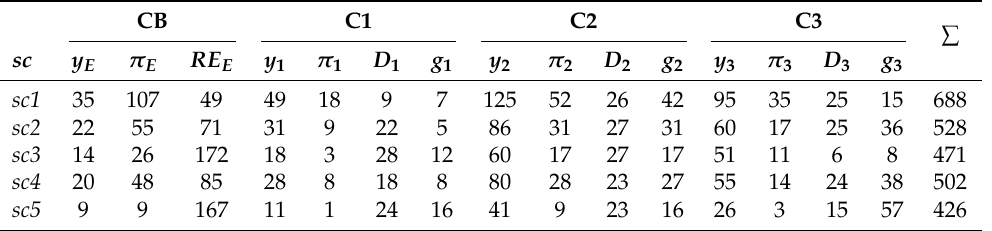
Table 12. Detailed objective function values, robustness experiment